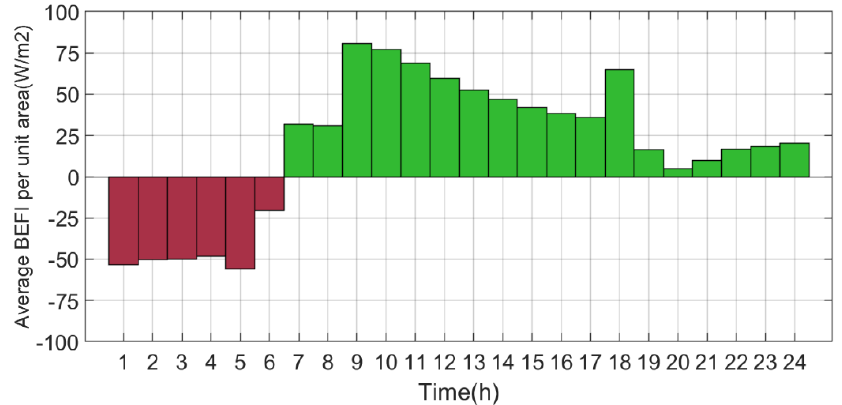
Figure 20. Hourly building energy flexibility in school.